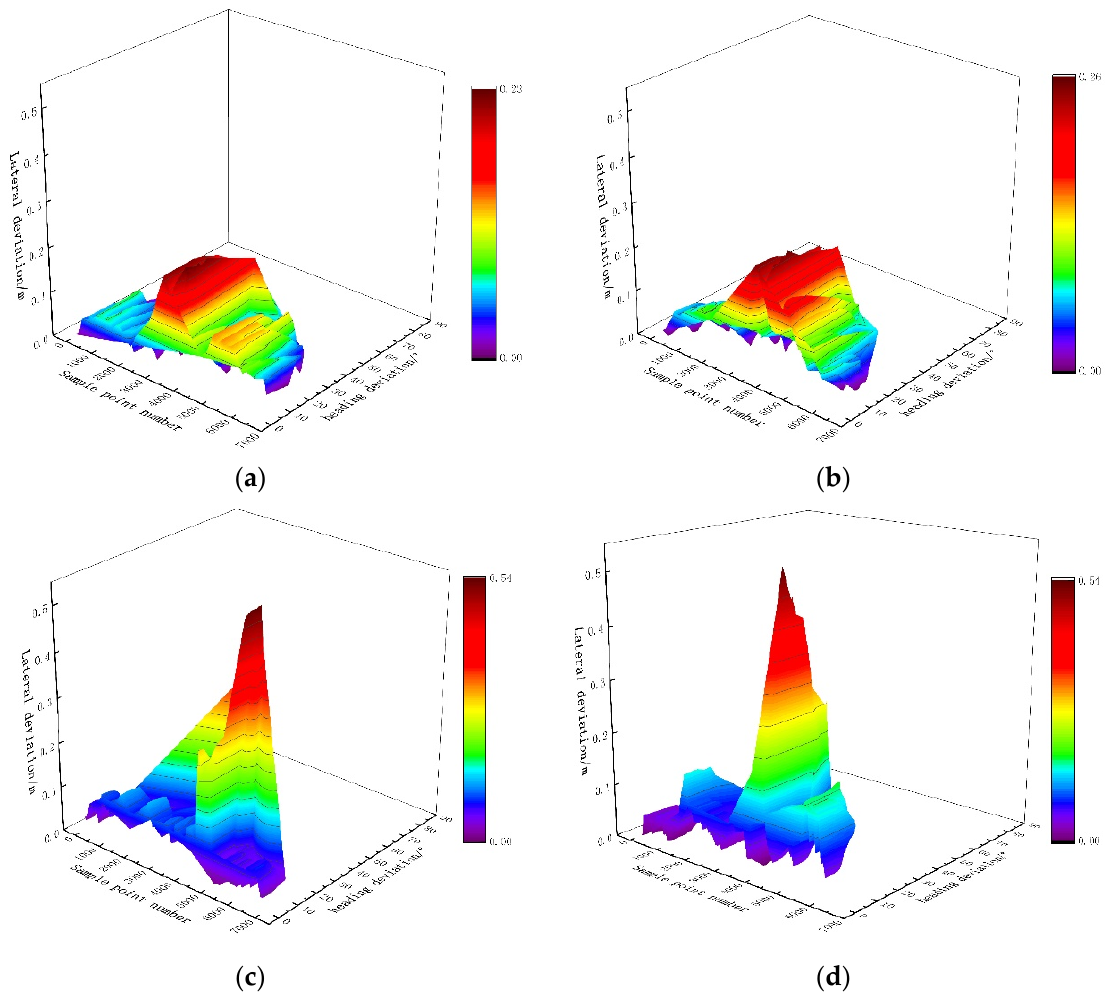
Figure 19. ( a , b ) The 3D maps of 0.36 m/s and 0.75 m/s path-tracking error for the Double-DQN method; ( c , d ) 3D maps of 0.36 m/s and 0.75 m/s path-tracking error for the virtual radar method.